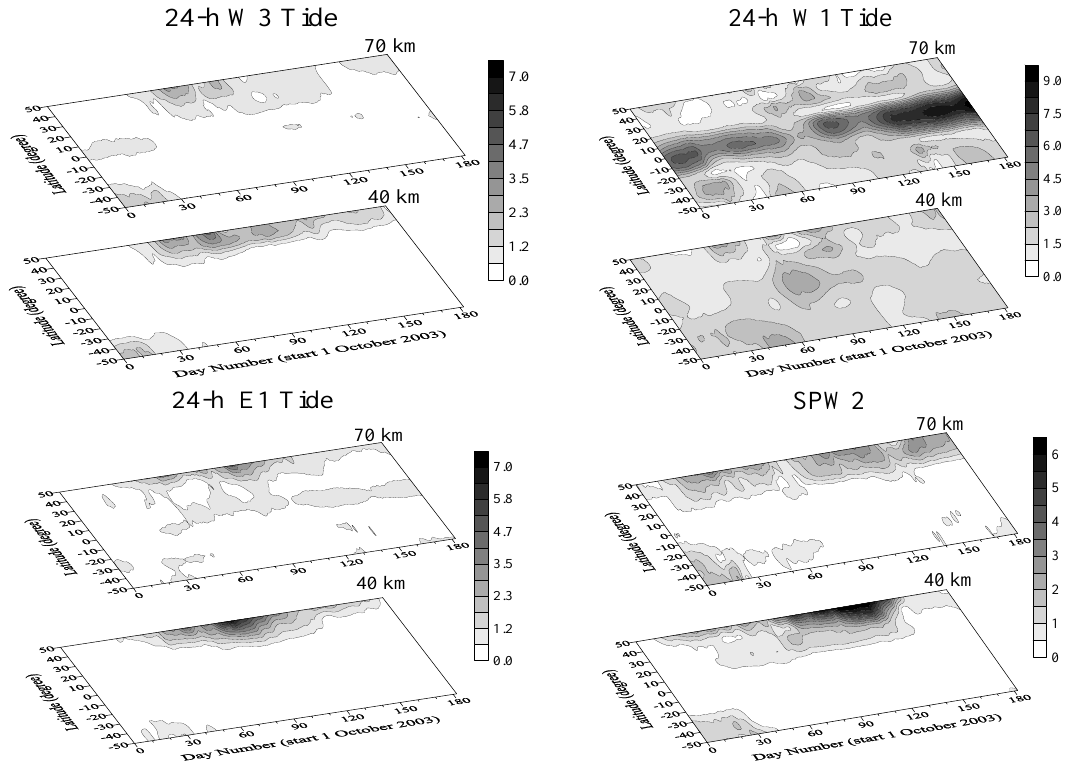
Fig. 7b. Latitude-time cross sections of the following amplitudes: nonmigrating W3 tide (upper left plot), nonmigrating E1 tide (bottom left plot), migrating W1 tide (upper right plot) and SPW2 (bottom right plot) at altitudes of 40km and